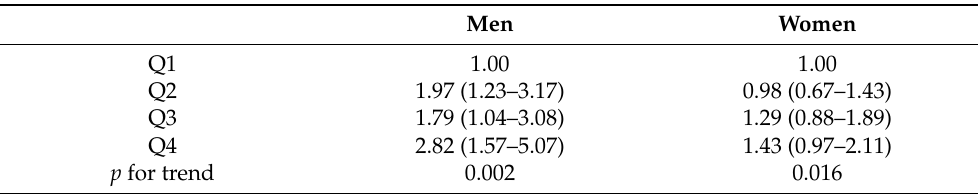
Table 3. Multiple regression analysis * between hand grip strength † and functional disability according to sex. Men